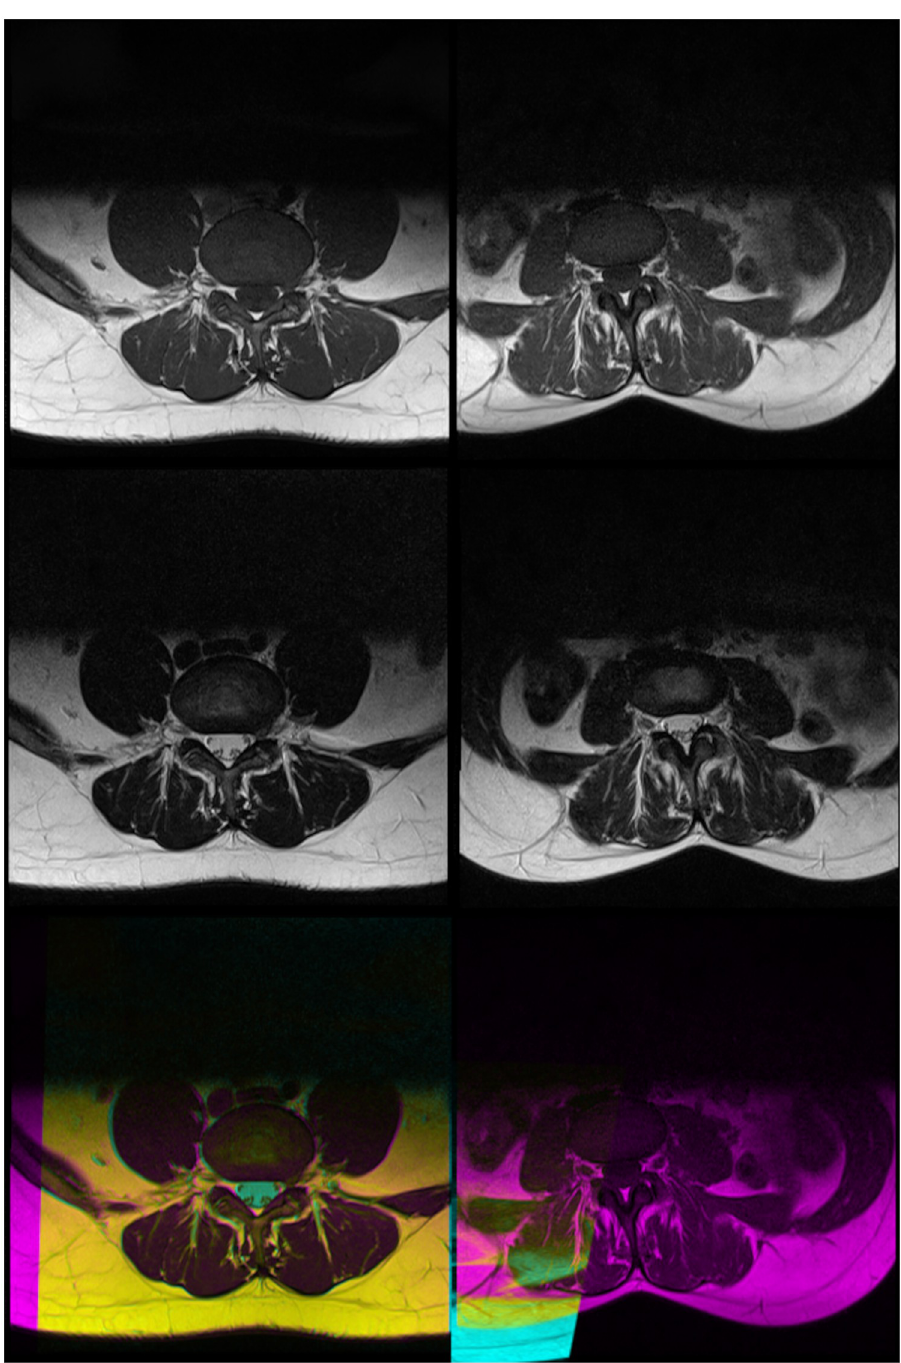
Fig 5. Two example cases where the image registration process succeeded (left column) and failed (right column). The top row shows the T1-weighted images, the middle row shows T2-weighted images, and the bottom row shows the resulting composite images after image